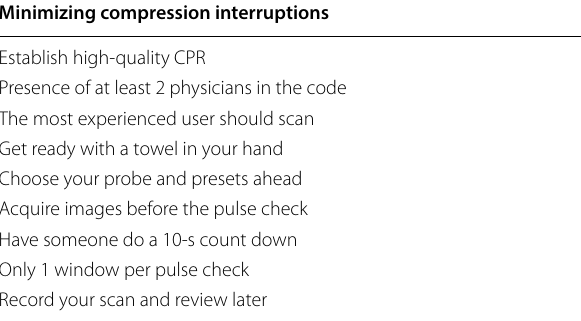
Table 1 Key points in faster image acquisition during